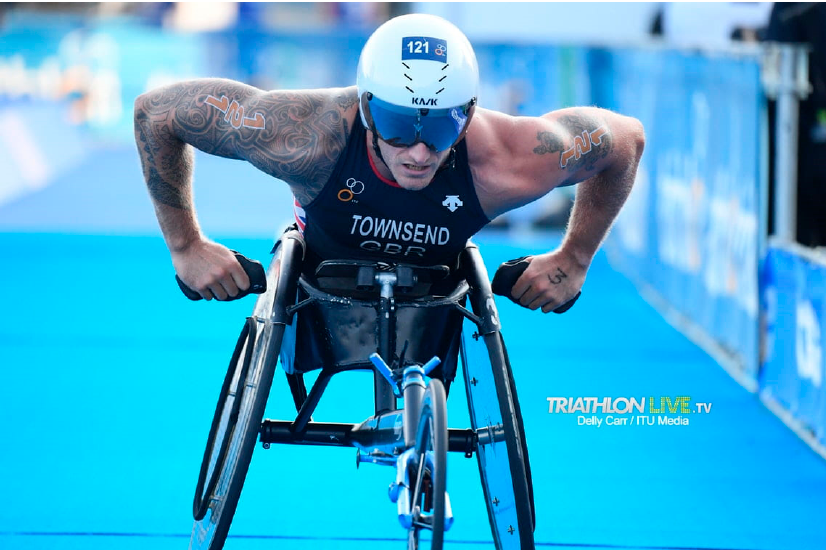
Figure 1. Wheelchair racing gloves are typically solid 3D structures held in a clenched fist. Propulsion is achieved by pushing the glove against a rotating rail.